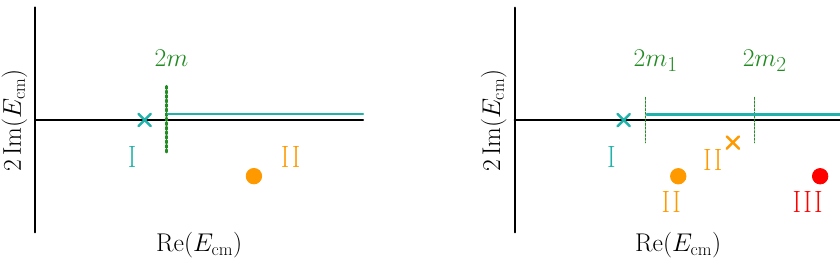
Figure 1 . Sketch of the pole locations in the scattering matrix t that typically affect the experi- mental rates on the physical axes (denoted by the cyan line) for one-channel scattering (left) and two coupled channels (right). The Roman numbers indicate the Riemann sheets where the poles are located according to eq. (2.4). Poles immediately below a threshold, indicated by crosses, can also have observable effects on the physical axes above the respective